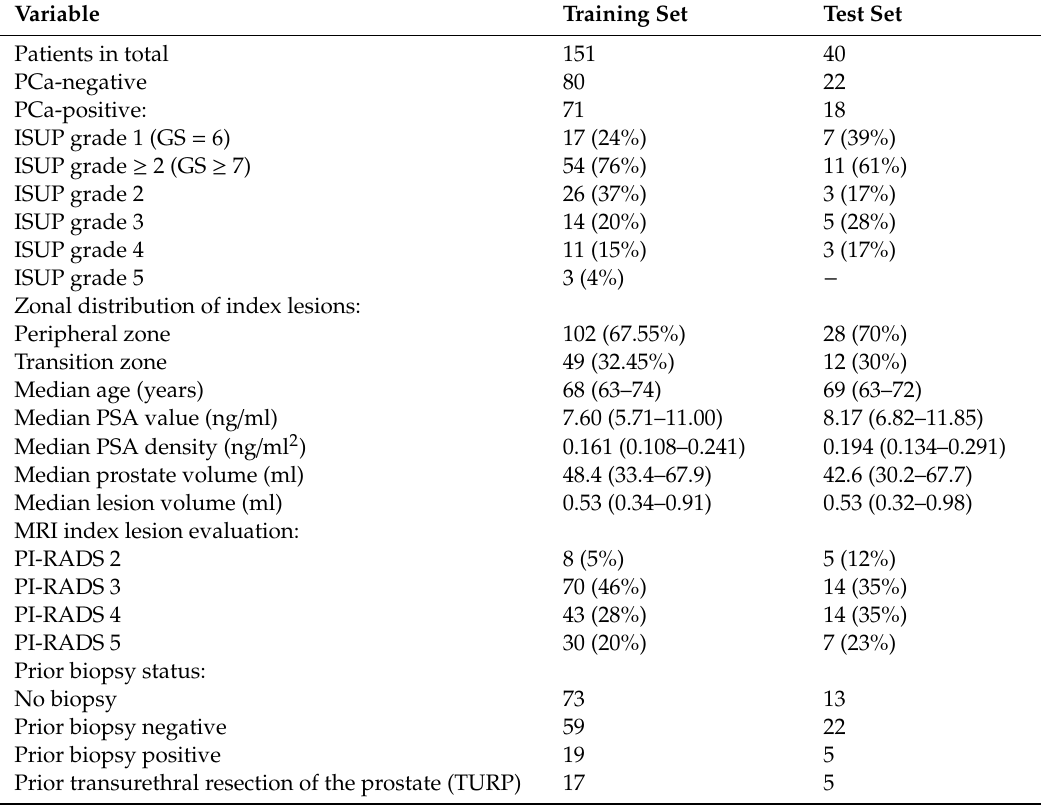
Table 1. Demographic and clinical characteristics as well as MRI findings of all 191 enrolled patients. Training